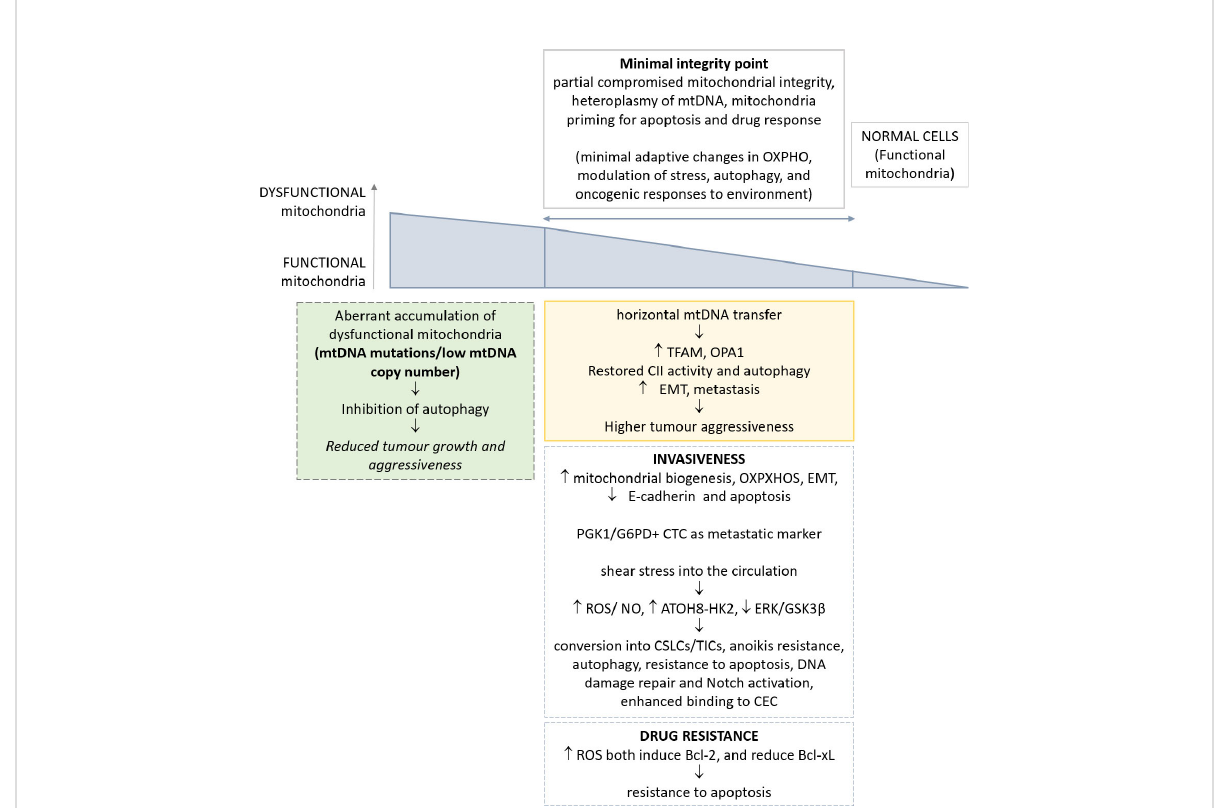
FIGURE 1 Schematic representation of the most relevant alterations reported in mitochondria, and their implications in CTC phenotype. The genetic and metabolic plasticity of tumour cells and the identi fi cation of a minimal integrity point threshold in mitochondria permit greater oncogenic/ metastatic potential in CTCs. The effects of such adaptations in CTCs are